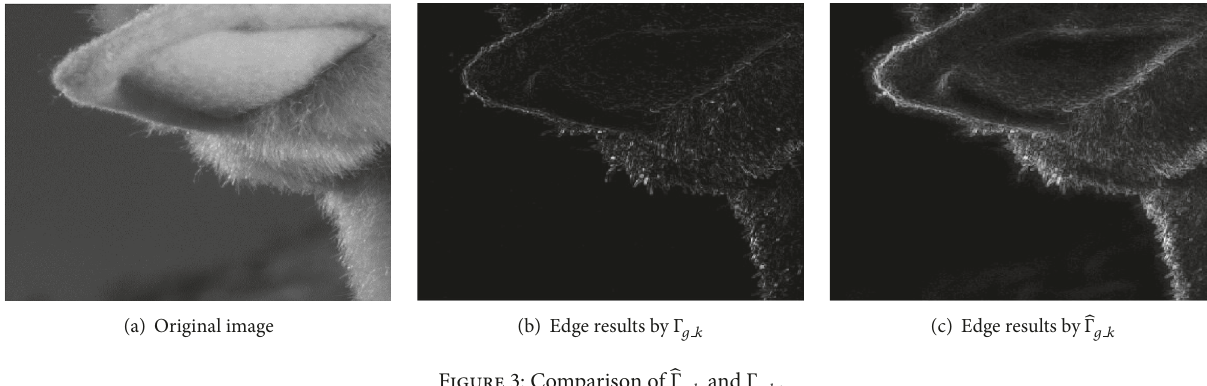
Figure 3: Comparison of